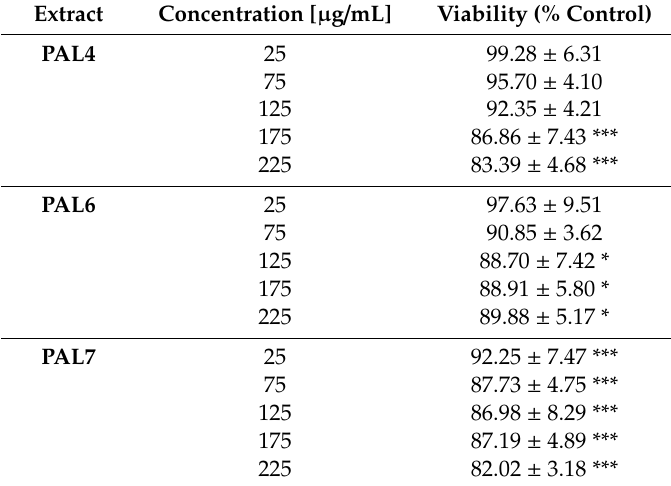
Table 2. The e ff ect of the PAL4, PAL6, and PAL7 on the cell viability of the HT-29 line studied using a neutral red (NR) uptake assay. The extracts worked in a dose-dependent manner. The values are compared to the control, regarded as 100%; * p < 0.01, ** p < 0.005, *** p < 0.001, one-way ANOVA, Dunnett’s test.